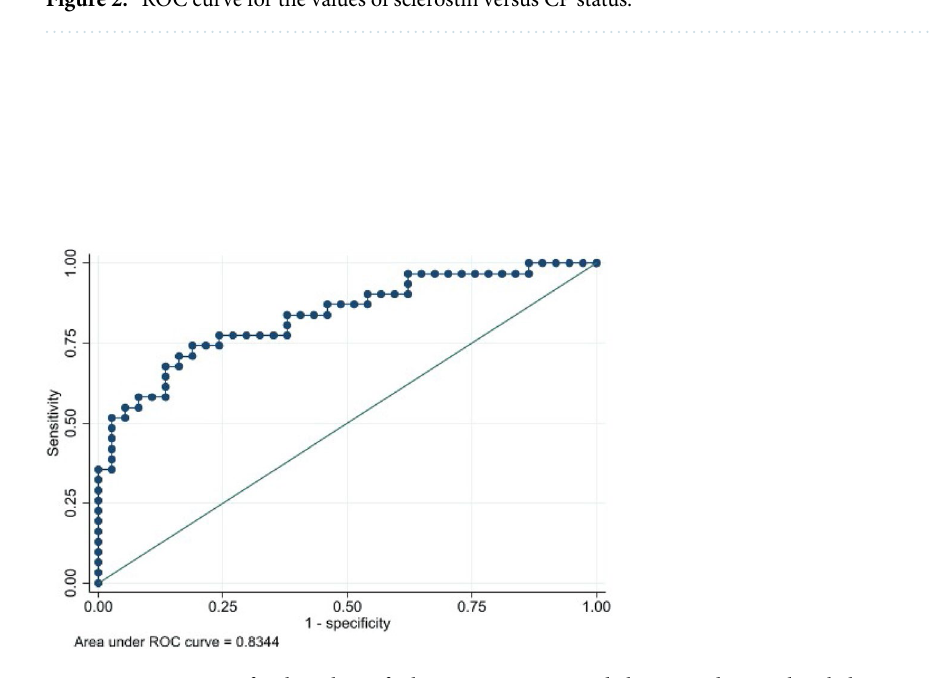
Figure 3. ROC curve for the values of sclerostin versus PWV dichotomized into values below or equal/above than 6.7